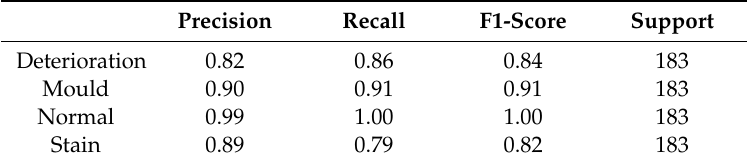
Figure 9. CNN-CAM localisation.